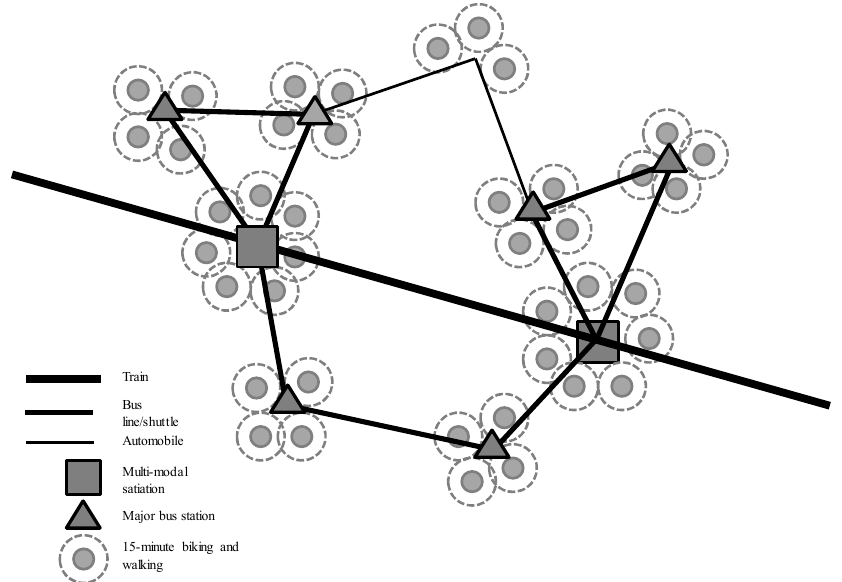
Figure 13. The diagram schematically illustrates a green transportation spatial hierarchy of a multi- modal system [29].